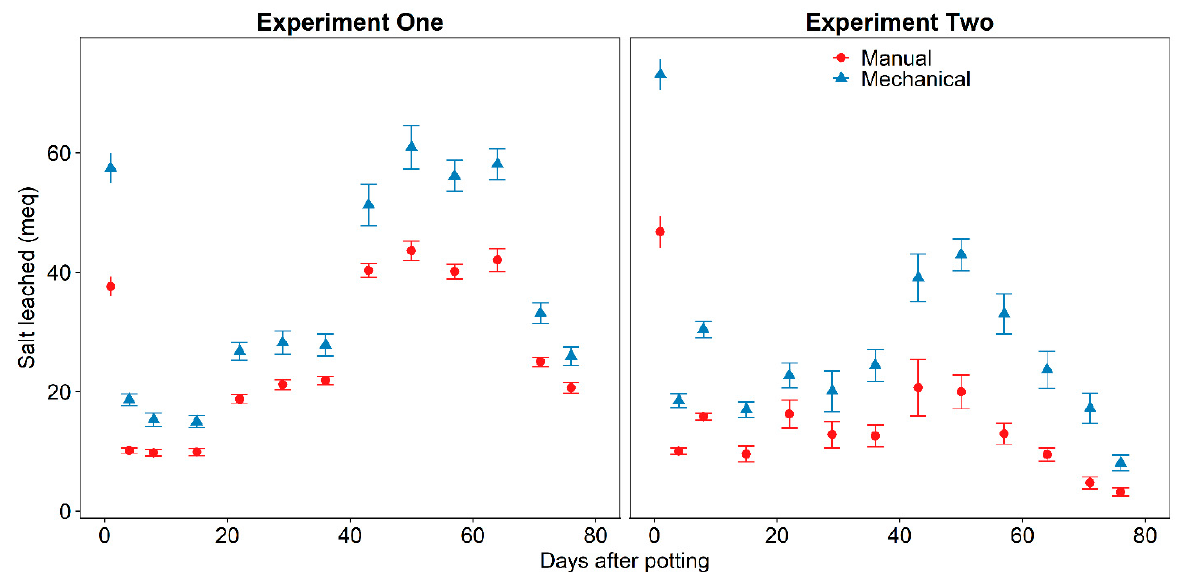
Figure 4. Salt leached from unplanted (Experiment One) or planted (Experiment Two) Douglas fir bark substrate and with either manually or mechanically incorporated Osmocote Plus 15-9-12 controlled release fertilizer. Error bars are standard error ( n = 10) of the mean.